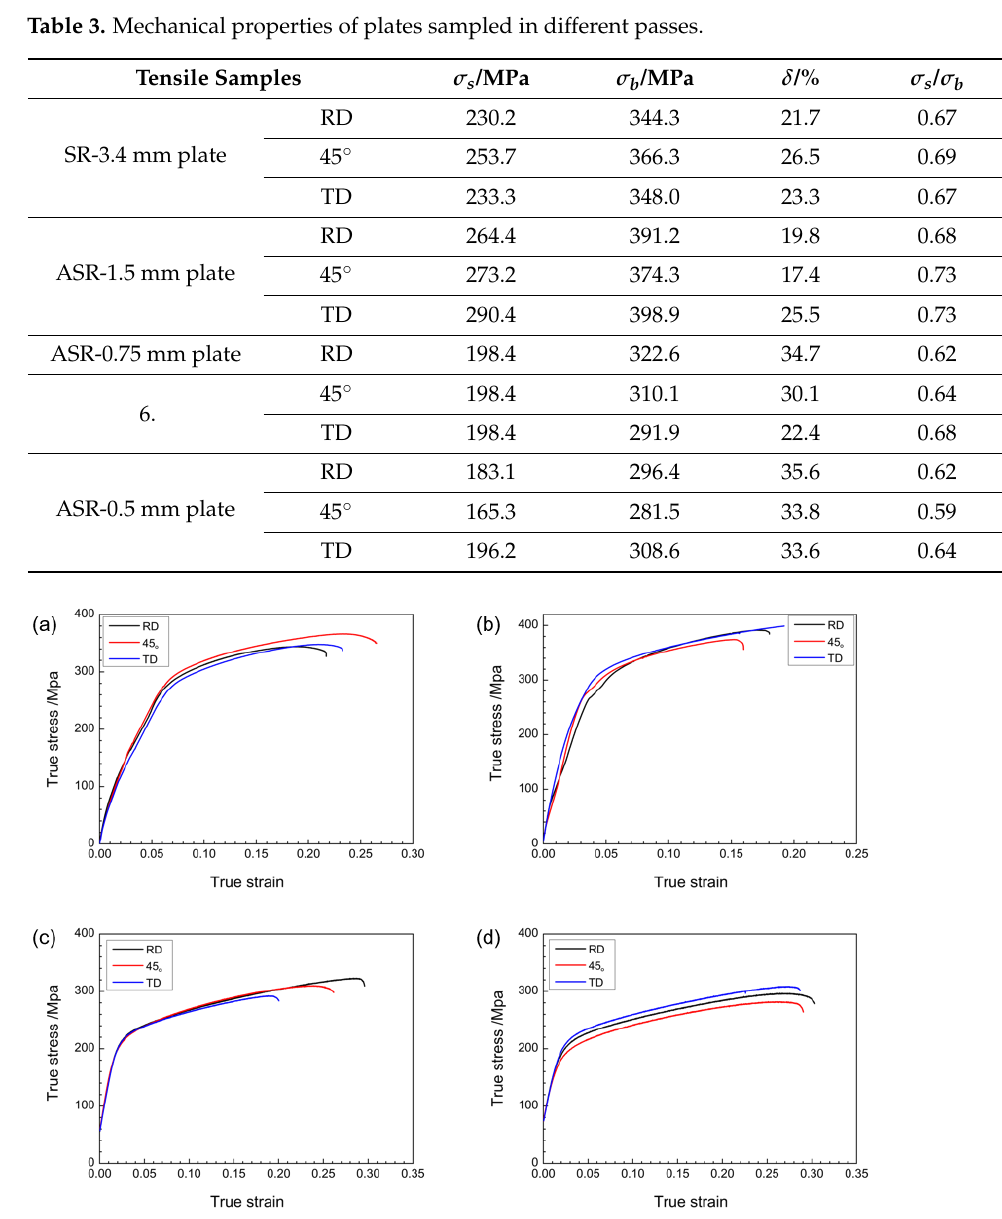
Table 3. Mechanical properties of plates sampled in different passes.